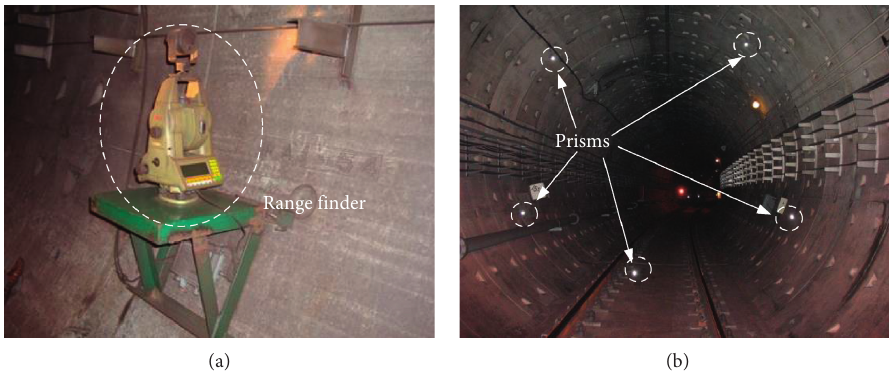
Figure 9: Photo in the actual tunnel: (a) laser range finder and (b)